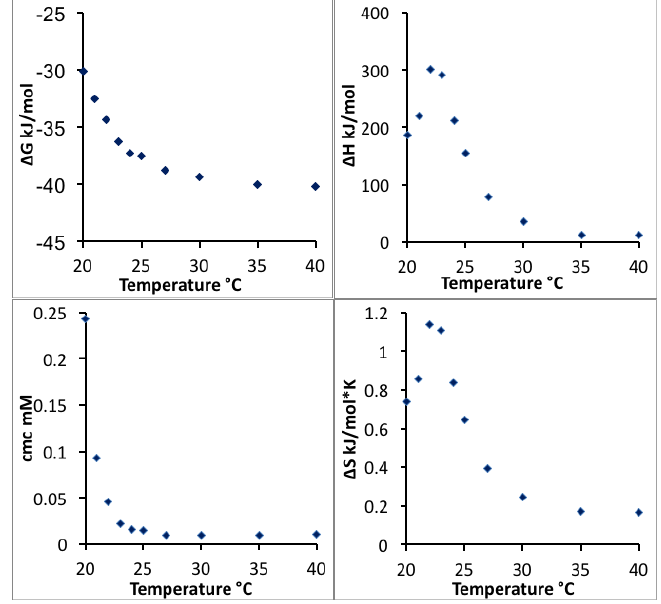
Figure 3. Micellization free energy, enthalpy, CMC and entropy of Pluronic P123 in water plotted as a function of temperature.